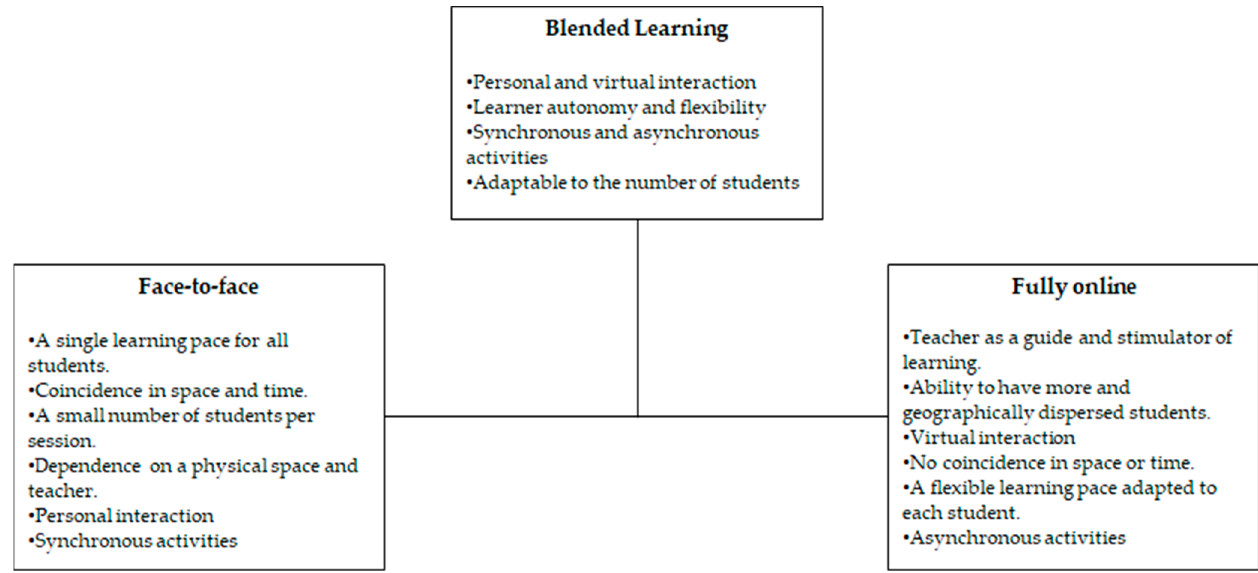
Figure 1. Characteristics of learning modalities.